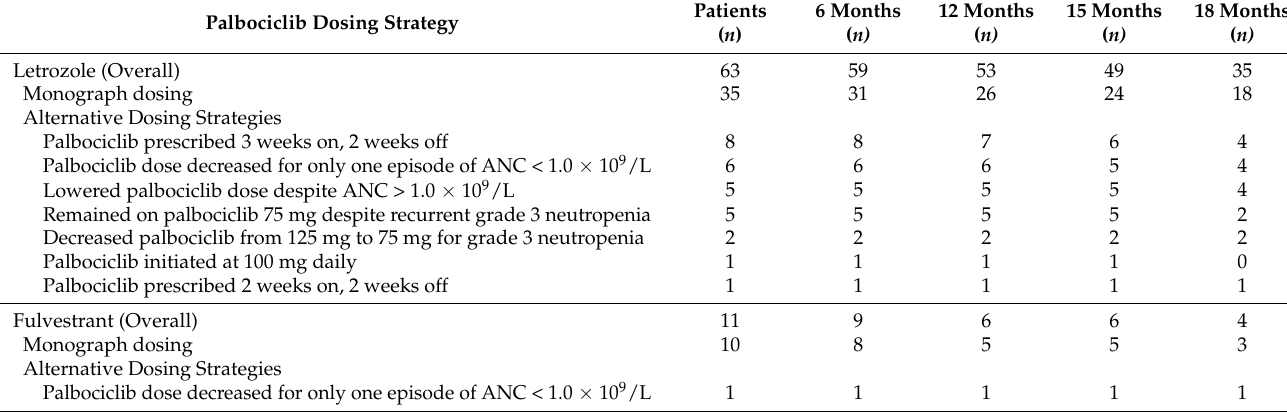
Table 3. Clinic patients remaining at risk of progression at 6, 12, 15, and 18 months receiving palbociclib in combination with letrozole or fulvestrant stratified by dosing strategy. Patients Palbociclib Dosing Strategy ( n